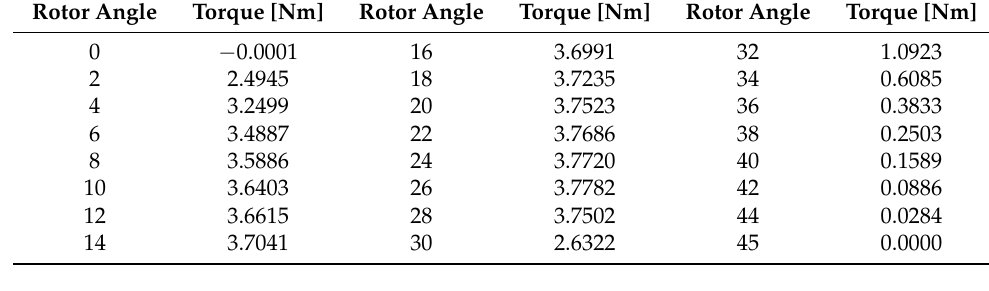
Figure 14. A 2D model of a 6/4 motor. Table 3. A 6/4 motor: torque values for individual angles derived from the model. Rotor Angle